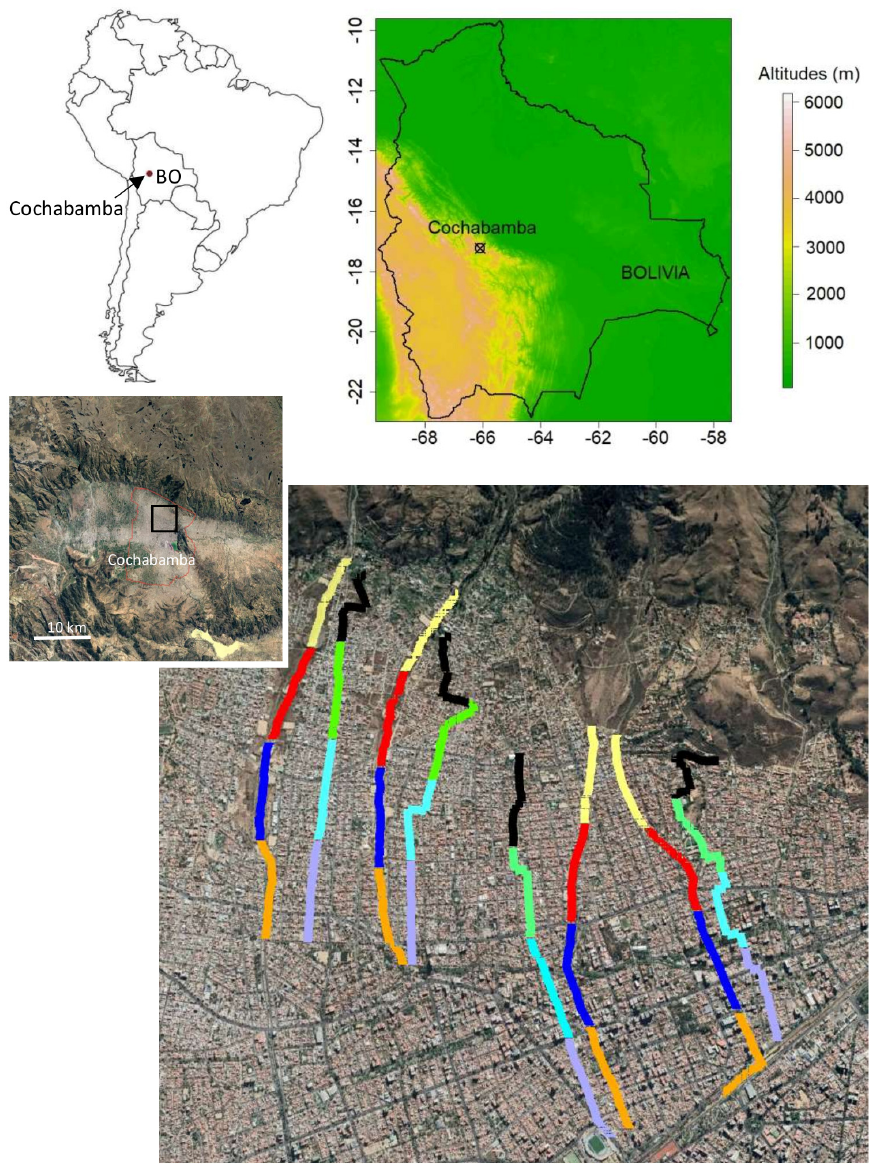
Figure 1. Cochabamba in Bolivia (BO, South America) is located at an altitude of 2,570 m a.s.l. The studied corridors begin on the border of the National Park of Tunari (750 m long sections; natural corridors: yellow, red, blue, and orange; sections of artificial corridors: black, green, light-blue, and